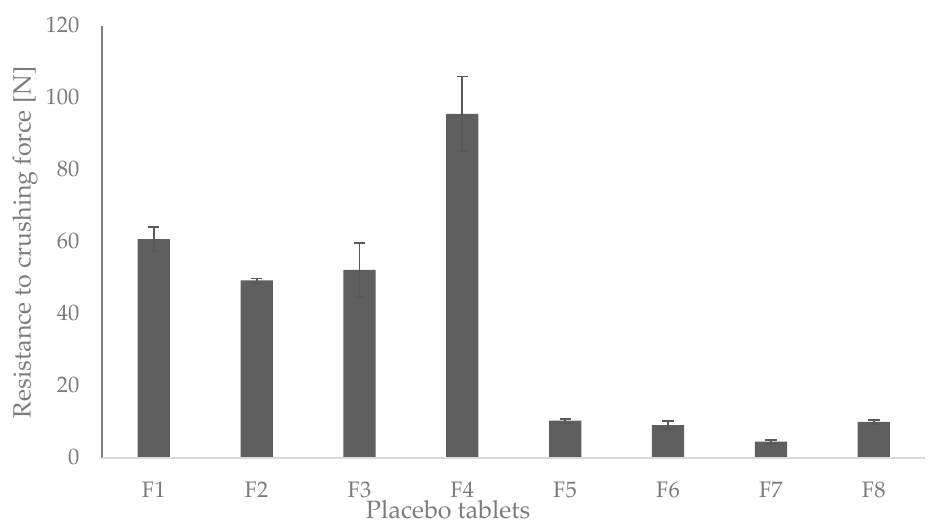
Figure 3. Resistance to crushing of LMT (F1–F8) and placebo tablets (T1–T8).